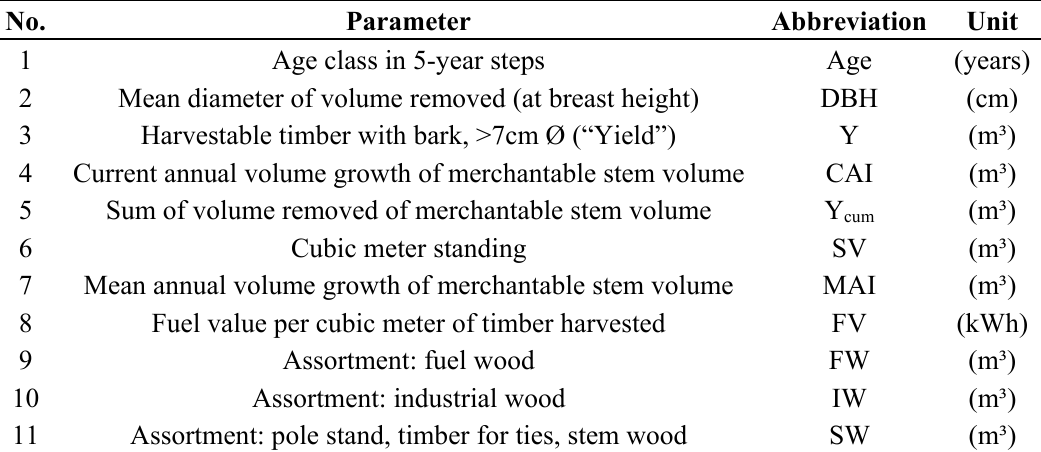
Table 1. Assessment parameters, which are addressed in the Biomass